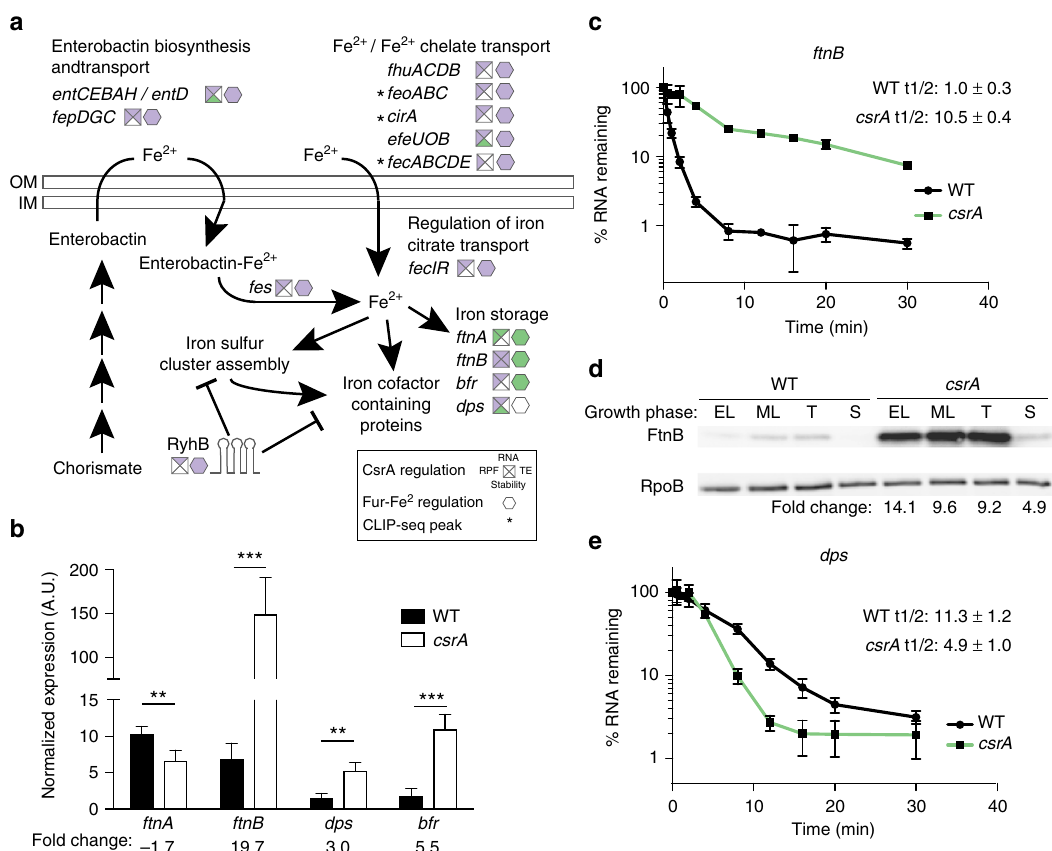
Fig. 6 CsrA regulates iron metabolism. a Summary of the effects of CsrA and Fur on iron-related genes. Squares near gene names show effect of CsrA on translation (RPF, left), RNA abundance (RNA, top), RNA stability (stability, bottom), and/or translation ef fi ciency (TE, right). Octagons indicate the effects of Fur-Fe 2+ on RNA abundance adapted from Seo et al. 49 Purple indicates repression and green indicates activation by CsrA or Fur. Asterisks indicate that CsrA CLIP-seq peak(s) are associated with the gene. b qRT-PCR analysis of steady-state ftnA , ftnB , dps , and bfr RNA levels normalized to 16s rRNA. Error bars show standard deviation from the mean of three independent experiments. Two tailed Student ’ s t test was used to determine statistical signi fi cance: ftnA ( n = 3, p = 0.0024), ftnB ( n = 3, p = 0.005), dps ( n = 3, p = 0.004), and bfr ( n = 3, p = 0.0016). c , e qRT-PCR analysis of ftnB ( c ) and dps ( e ) RNA stability in wild-type (WT) and csrA mutant strains. Error bars show standard deviation from the mean of two independent experiments. Half-life was manually determined from the linear component of the decay curve. Two tailed Student ’ s t test was used to determine statistical signi fi cance of the change in half-life: ftnB ( n = 2, p = 0.0011), and dps ( n = 2, p = 0.0258). d Western blot showing 3xFLAG-FtnB levels throughout the growth curve (EL early log, ML mid-log, T transition to stationary phase, and S stationary phase) in WT and csrA mutant strains. Full blots are shown in Supplementary Fig. 18. Densitometry was normalized to RpoB levels before calculating fold changes. This experiment was repeated twice with similar